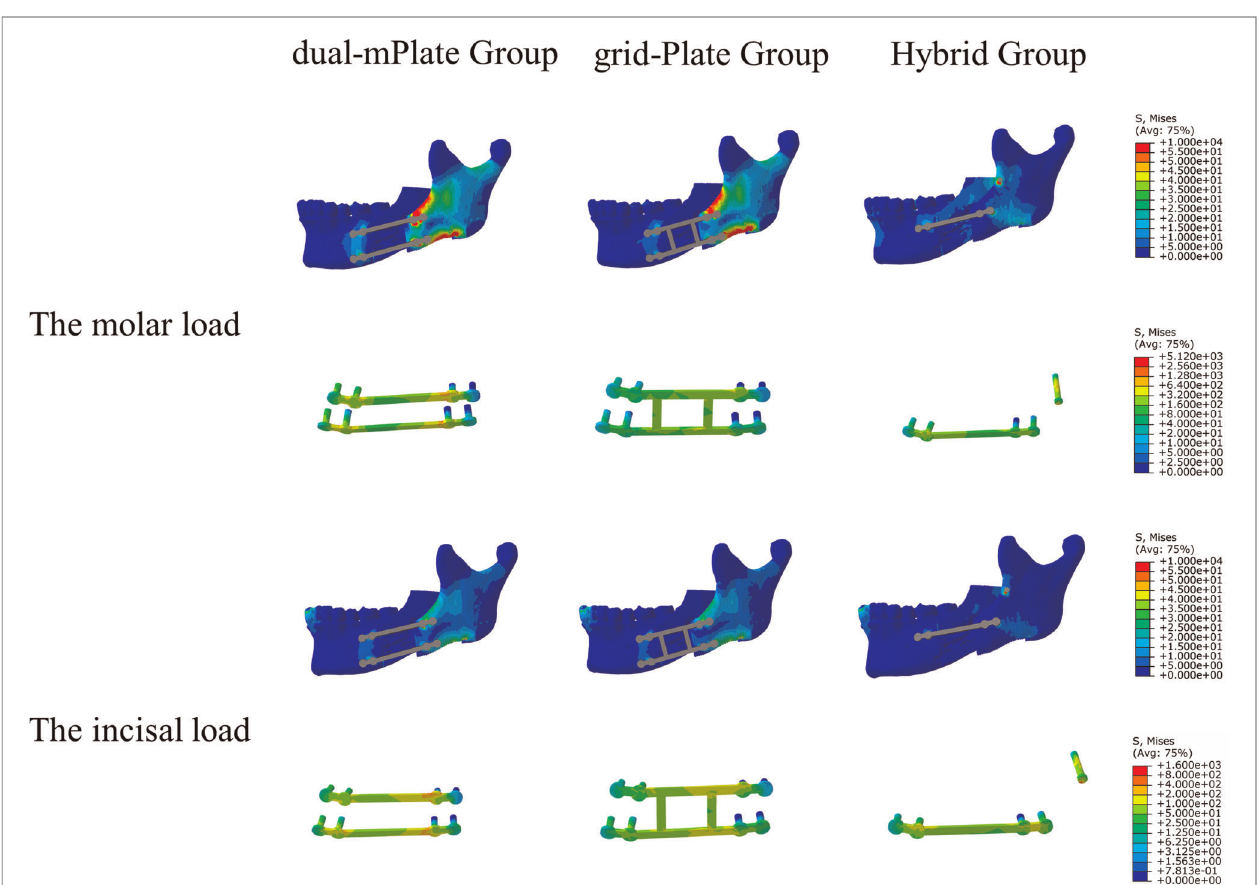
FIGURE 7 | Distribution of von Mises stress on mandibles and the von Mises stresses results for seven fi xation methods with a 20 mm